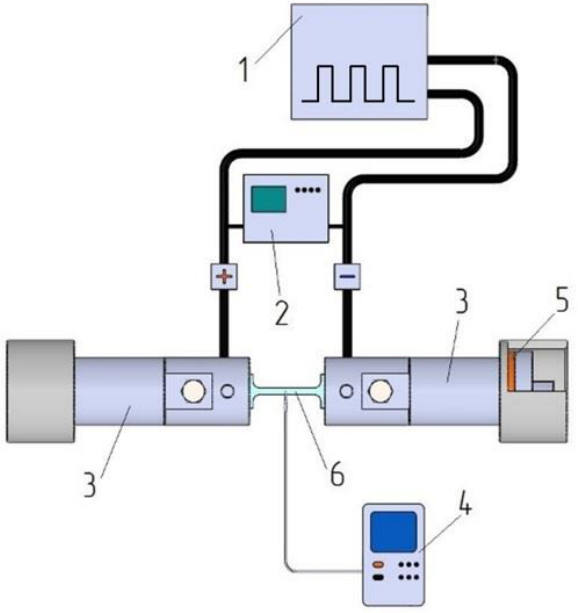
Figure 3. Diagram of the test setup: 1 — pulse current generator; 2 — oscilloscope; 3 — captures; 4 — thermocouple; 5 — isolation; 6 — sample.